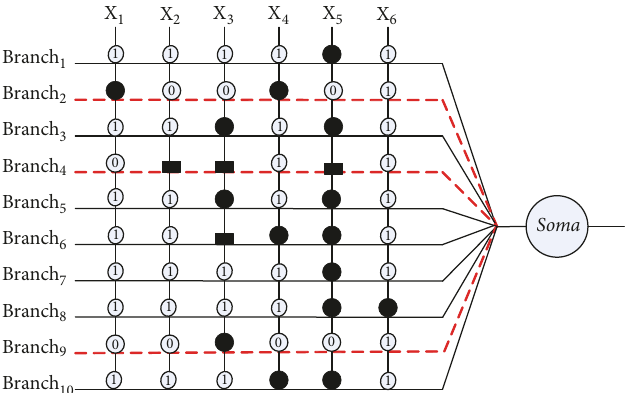
Figure 9: The dendritic morphology of the Qualitative Bankruptcy data set after dendritic pruning.